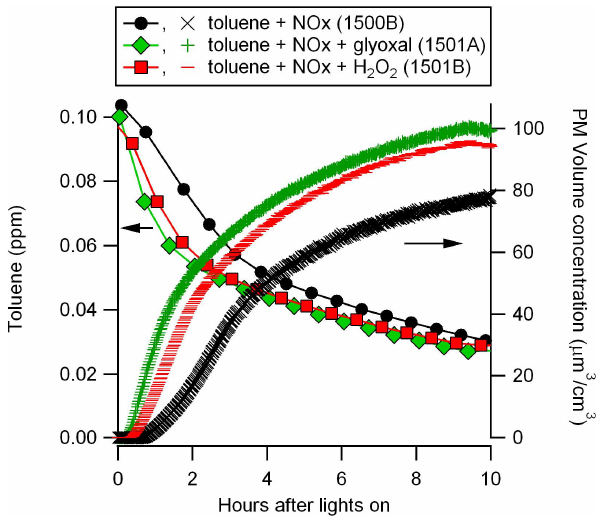
Fig. 4. Evaluation of glyoxal impact as a radical source. Addition of glyoxal (green trace) and H 2 O 2 (red trace) resulted in nearly identi- cal toluene decay and SOA formation, indicating that glyoxal acted as a radical source, instead of an oligomer precursor.